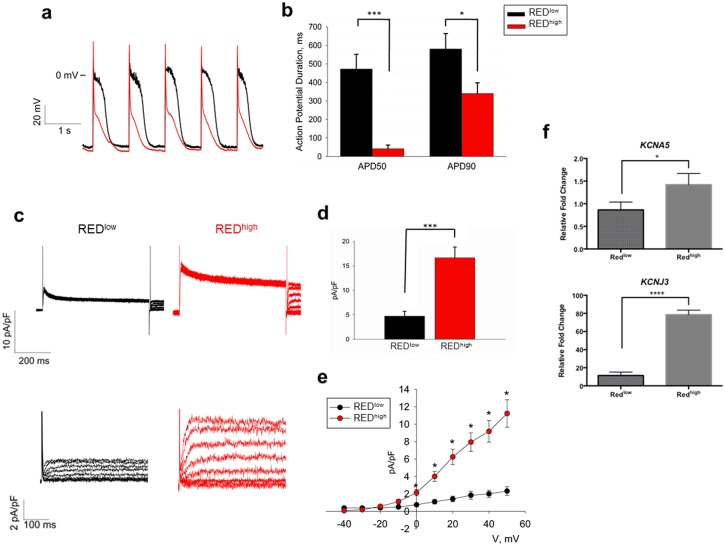
Redhigh cells display electrophysiological properties similar to atrial cardiomyocytes.(a) Representative triggered action potential traces recorded from redhigh and redlow cells. (b) Quantification of APD50 and APD90 for redhigh (n = 15) and redlow (n = 10) cells (***p<0.001, *p<0.05). (c–e) Expression of depolarization-activated potassium currents. (c) Upper panel: representative instantaneous outward currents. Lower panel: representative sustained potassium currents. (d) Comparison of peak instantaneous outward currents between redhigh (n = 7) and redlow (n = 8) cells. (e) Comparison of I–V curves of sustained potassium currents between redhigh and redlow cells (***p<0.001). (f) qPCR for gene expression of the IKur subunit KCNA5 and IKAch subunit KCNJ3, revealing increased expression in redhigh cells (*p<0.05, ****p<0.0001). All genes normalized to expression of GAPDH and relative to gene expression in EBs.